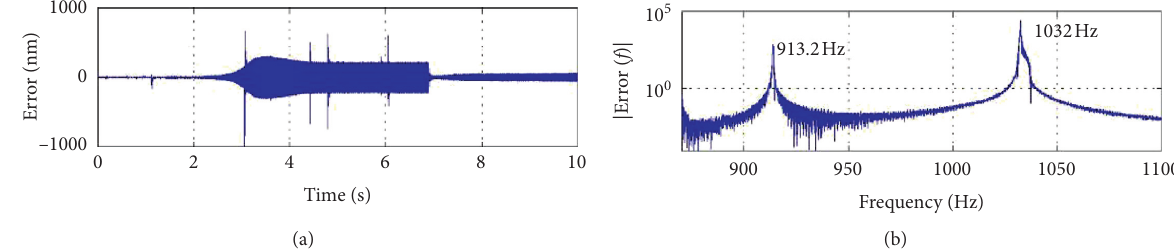
Figure 6: Z directional static error signal and its unilateral amplitude power spectrum. (a) Z directional static error signal. (b) Unilateral amplitude power spectrum of Z directional static error signal. Table 1: Intrinsic parameters of flexible modal structures.